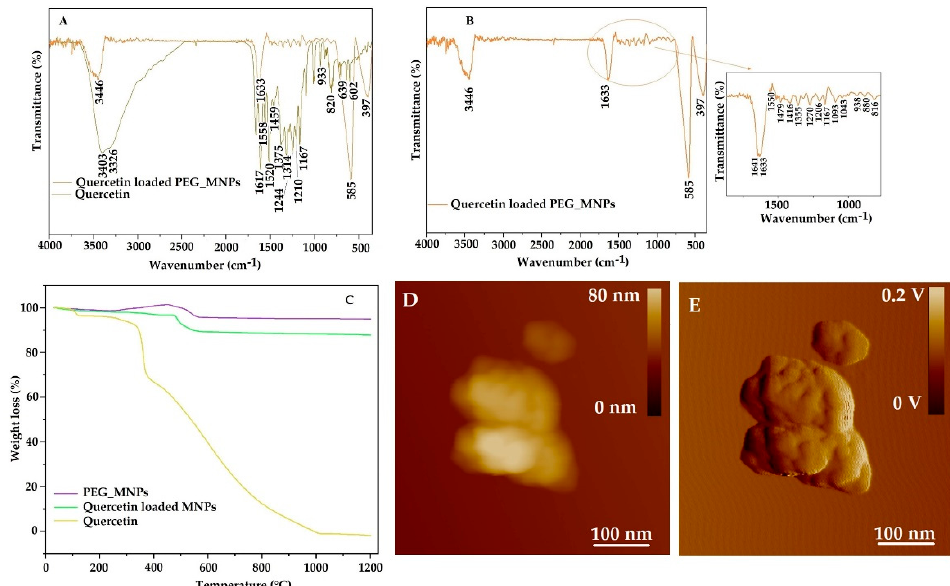
Figure 6. FTIR spectra of ( A ) quercetin and quercetin-loaded MNPs; ( B ) zoomed spectrum of quercetin-loaded MNPs in the region of quercetin reach bands; ( C ) TGA curves of PEG-coated MNPs, quercetin and quercetin-loaded MNPs. Morphology of quercetin-loaded MNPs on the 2D height AFM image ( D ) and 2D-amplitude AFM image ( E ).